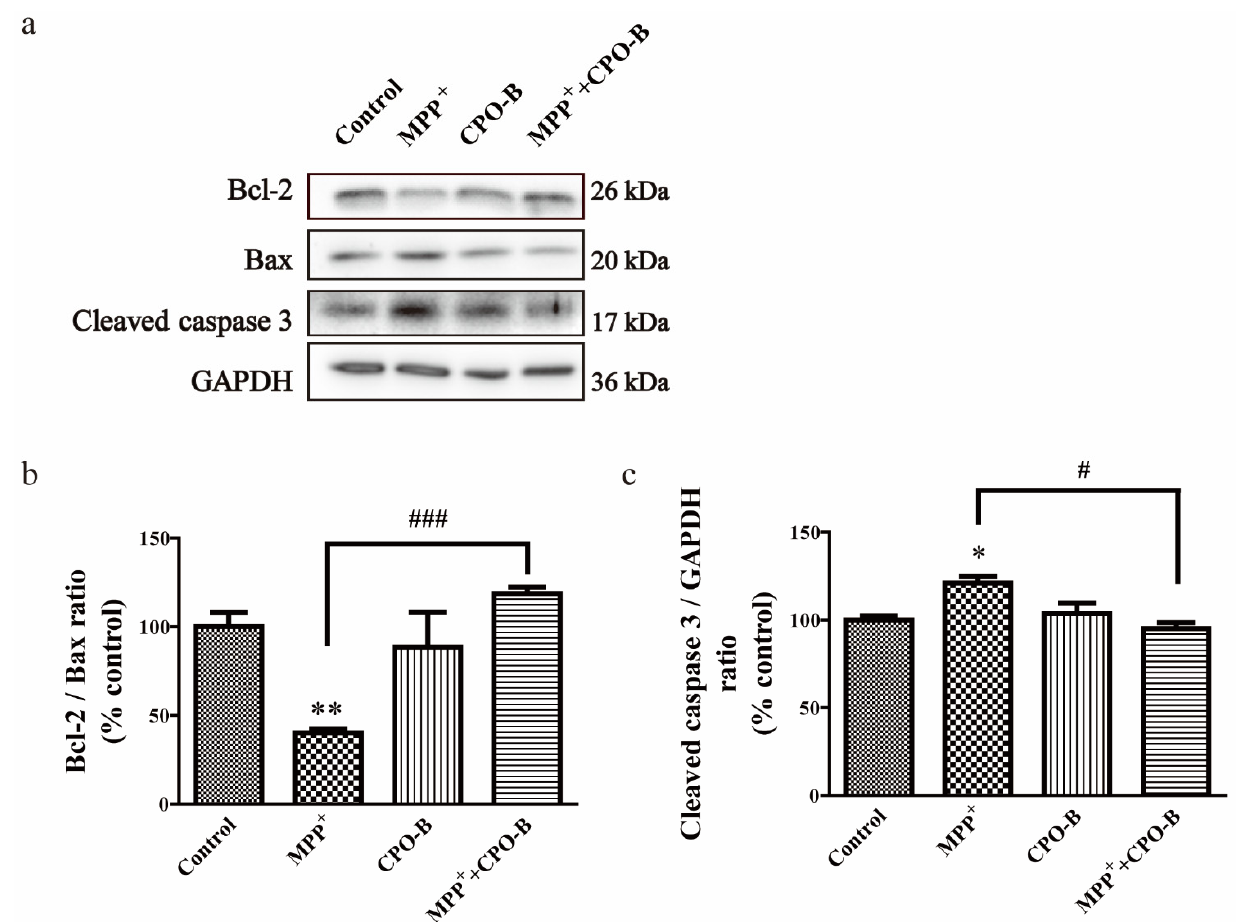
Figure 2. The effect of CPO-B on MPP + -induced alteration of Bcl-2/Bax expression ( b , n = 3) and cleaved caspase-3 expression ( c , n = 3). The top panel shows the representative Western blots ( a ); the values (mean ± SEM) were standardized to the percentage of control; symbol * indicates the difference between control and other treatments; symbol # indicates the difference between MPP + and MPP + +CPO-B; * p < 0.05, ** p < 0.01, # p < 0.05, ### p < 0.001; CPO-B, B-type cinnamon procyanidin oligomer; MPP + , 1-methyl-4-phenylpyridinium; Bcl-2, B-cell lymphoma 2; Bax, Bcl-2-associated X protein; GAPDH, glyceraldehyde 3-phosphate dehydrogenase.